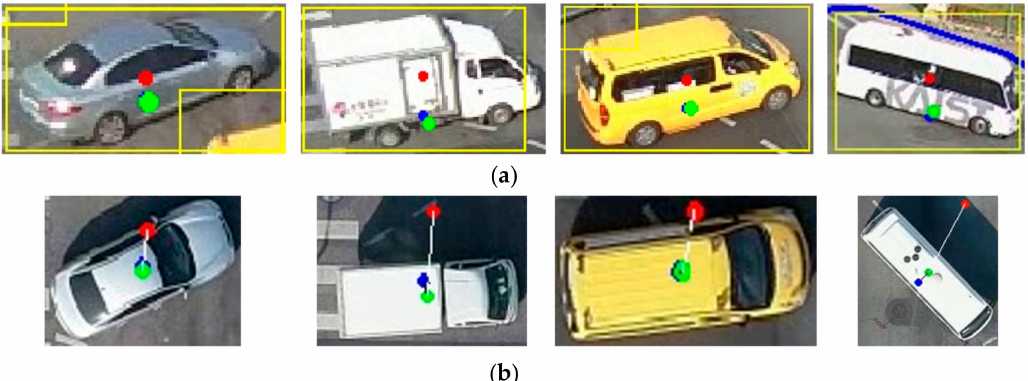
Figure 12. The projected center points of moving vehicles in closed-circuit television (CCTV) camera images and orthophotos: ( a ) CCTV camera images; ( b ) orthophoto images. (Green point: ground truth, blue point: results of the proposed algorithm, and red point: results of the conventional